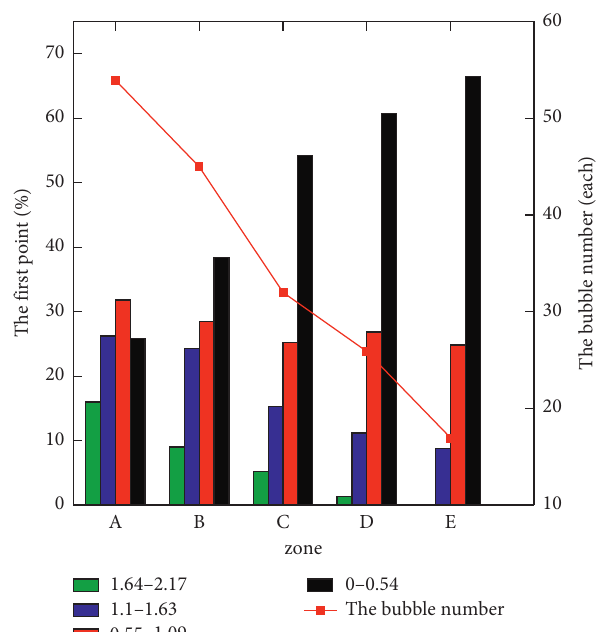
Figure 18: Distribution of the number and size of bubbles in each region. Table 1: The size distribution of bubbles in different regions. Region